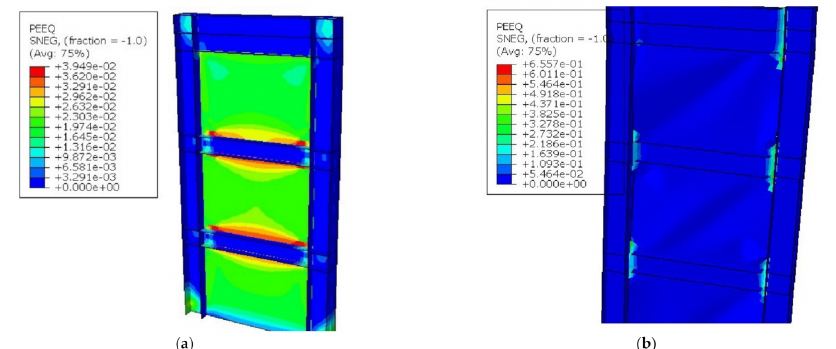
Figure 10. Forming of plastic hinge location in the initial and modified models: ( a ) original model and ( b ) modified model (PEEQ: represented in ABAQUS as the equivalent plastic strain, SNEG: surface negative).